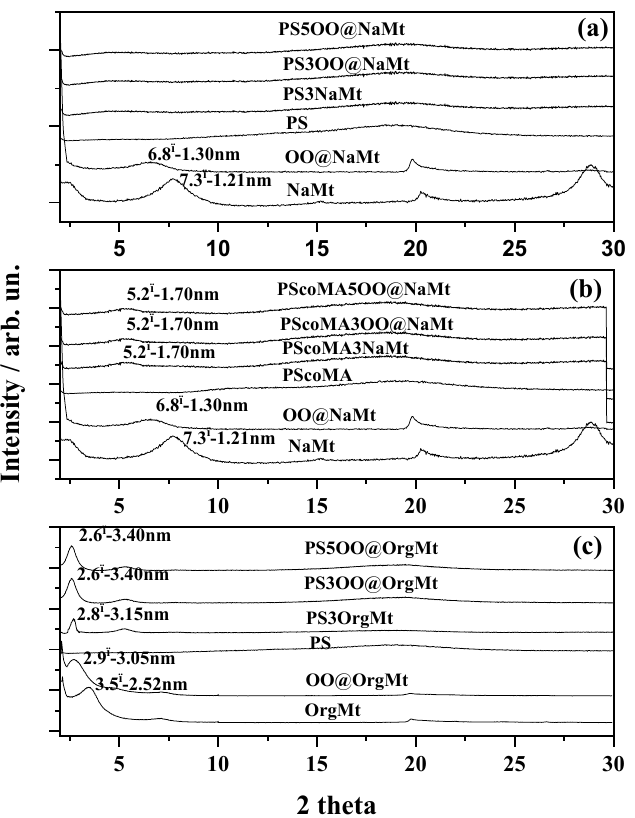
Figure 2. XRD plots of all PS/OO@NaMt, PSOO@OrgMt, PScoMA/OO@NaMt films, OO@NaMt, OO@OrgMt nanostructures and, NaMt, and OrgMt clays.